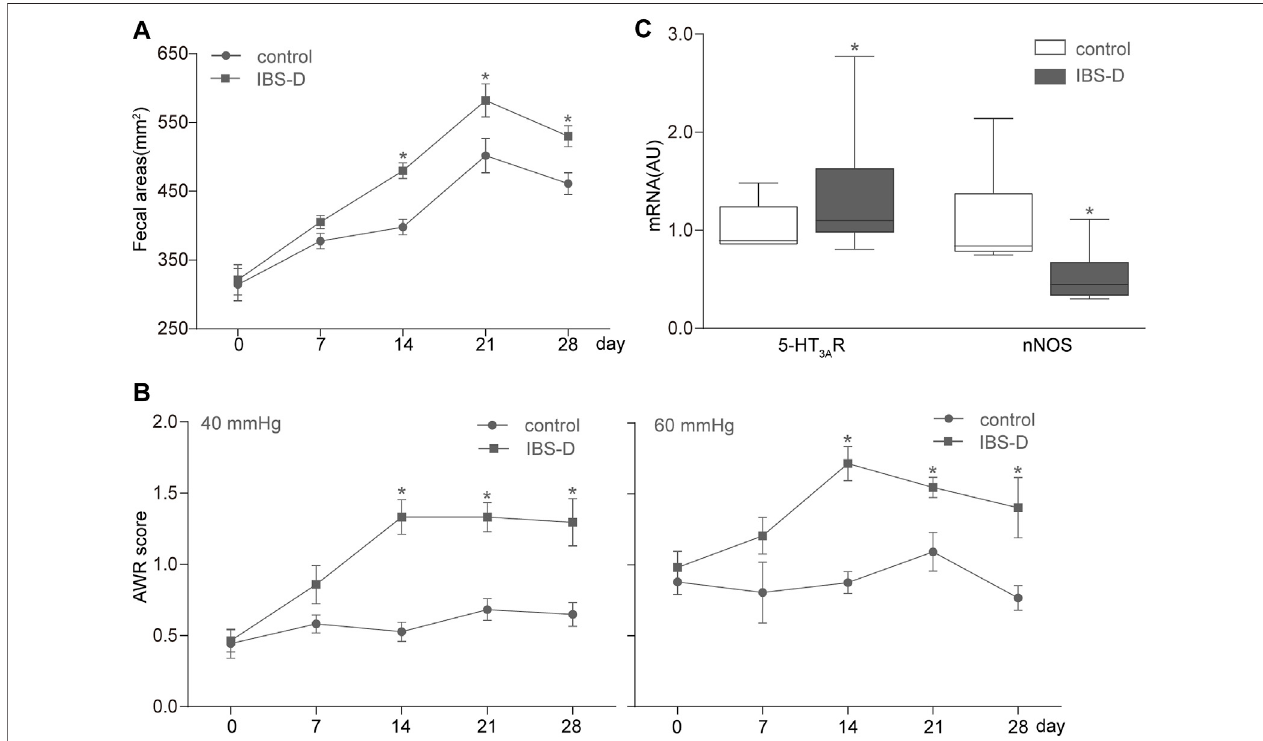
FIGURE3| EstablishmentoftheIBS-Dratmodel. (A,B) MeasurementresultsoffecalareasandAWRscoresat40and60 mmHgondays0,7,14,21,and28. (C) Boxand whisker plotsofthe distribution and mean expression levelsof5-HT 3A RandnNOS inthecolonic tissues ofthe controland IBS-Dgroups. Dataarerepresented as mean ± SEM. n (cid:2) 6 – 12 rats per group. *denotes p < 0.05 compared with the control group.